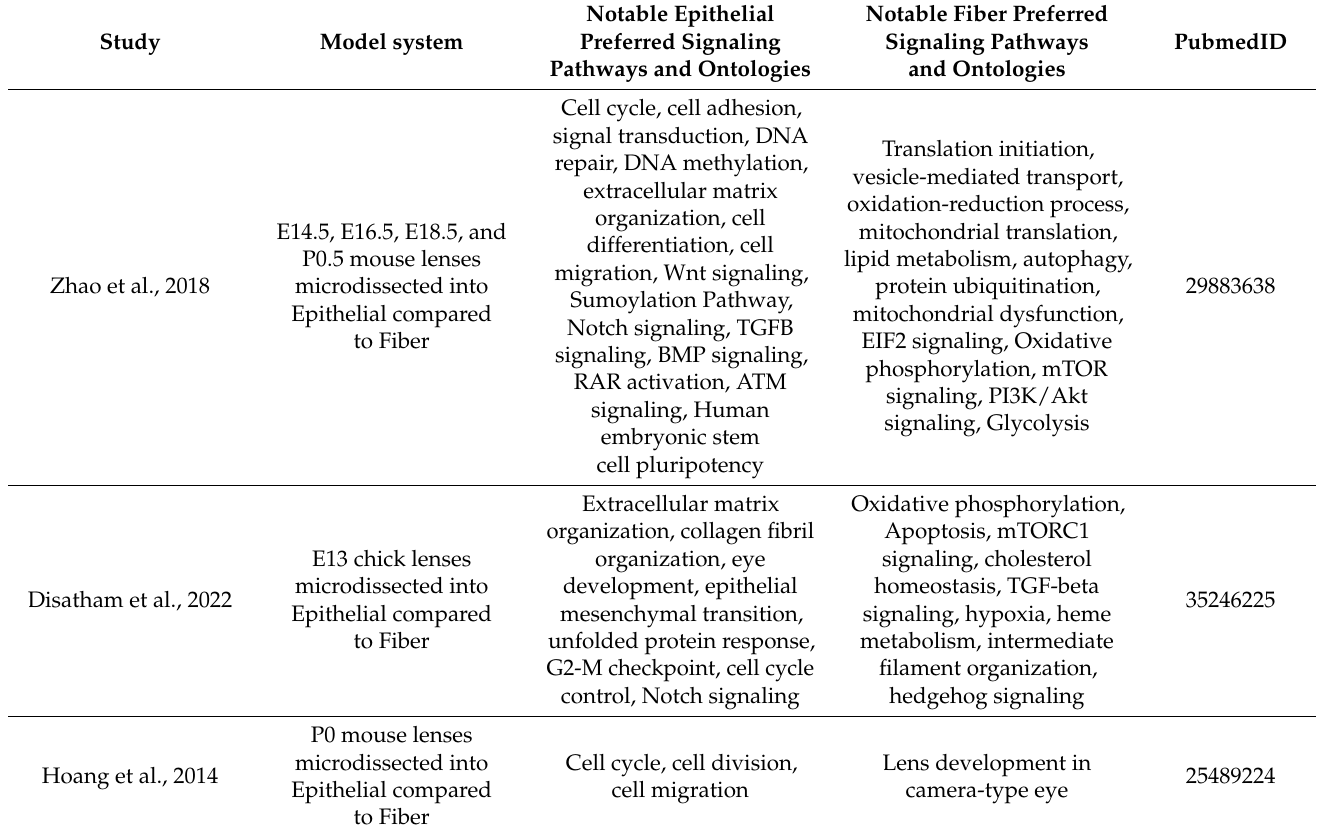
Table 2. Cell signaling pathways associated with epithelial or fiber cell genes from multiple RNA-seq studies in chicken and mouse